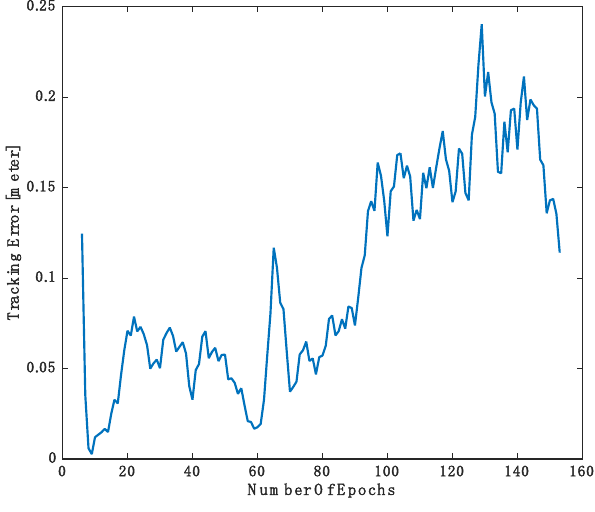
Figure 10. Tracking of ( a ) a cyclist and ( b ) a car over time. The car goes too far after a few seconds and it is not an object of interest anymore.